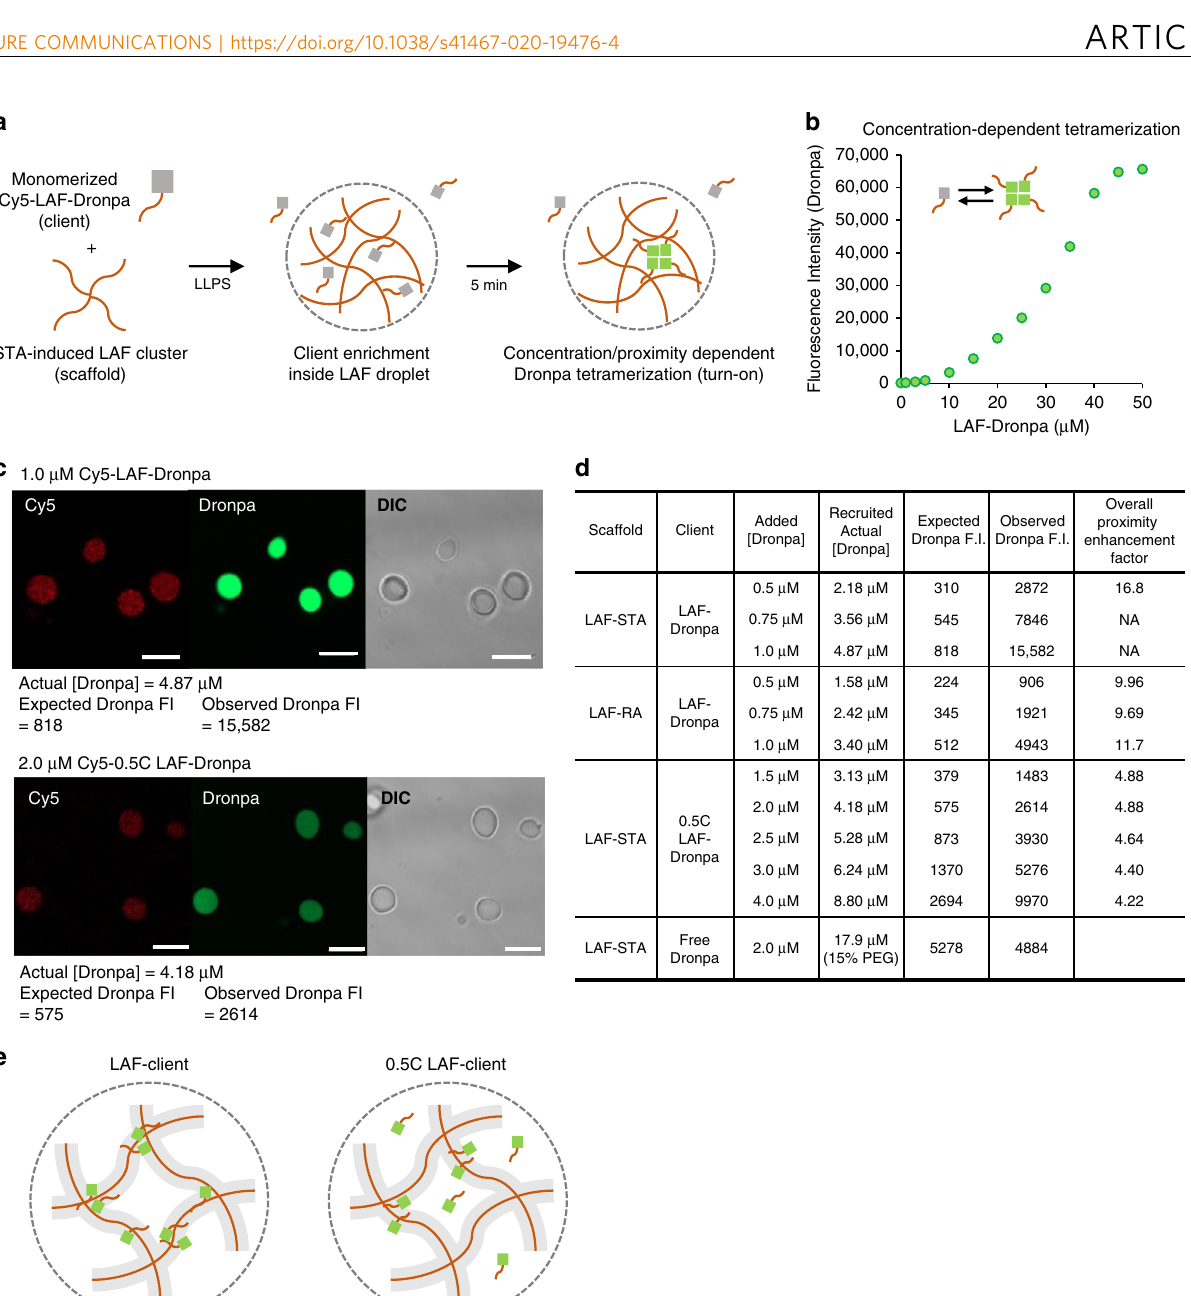
Fig. 6 Quantitative measurement of protein interaction enhancement inside IDR compartments. a Schematic illustration of LAF clustering-mediated droplet formation and monomerized Cy5-LAF-Dronpa client enrichment inside droplets, followed by proximity-dependent Dronpa tetramerization. b Dronpa fl uorescence signals of concentration-varied LAF-Dronpa after 10 s 488 nm light activation for Dronpa monomerization and 4 min incubation for concentration-dependent tetramerization. c Cy5 and Dronpa fl uorescence images of LAF droplets with mixed 1 μ M client LAF-Dronpa (top) or 2 μ M 0.5 C LAF-Dronpa (bottom). Calculated actual (Cy5) client concentrations and expected/observed Dronpa fl uorescent intensities (FI) are indicated below the images. Scale bars: 10 μ m. d Overall proximity enhancement factors with added Dronpa concentration, recruited actual Dronpa concentration inside droplets, expected Dronpa FI based on the actual [Dronpa], and observed Dronpa FI for various scaffold and client systems. e The proposed mechanism of proximity enhancement inside IDR droplets for LAF-Dronpa (left; strong scaffold – client interaction) or 0.5 C LAF-Dronpa (right; weak scaffold – client interaction). Potential client occupying volumes around scaffold protein networks are indicated in